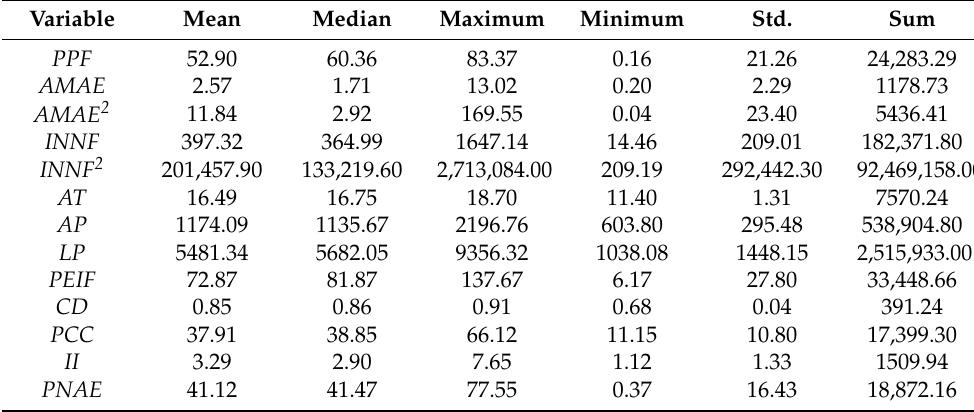
Table 2. Statistical description of the